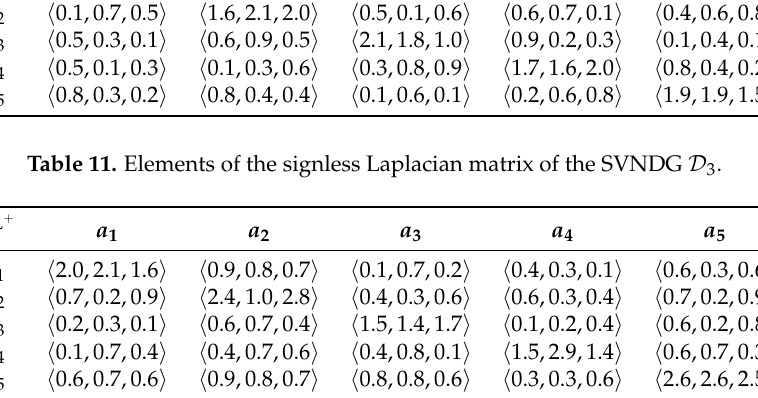
Table 10. Elements of the signless Laplacian matrix of the SVNDG